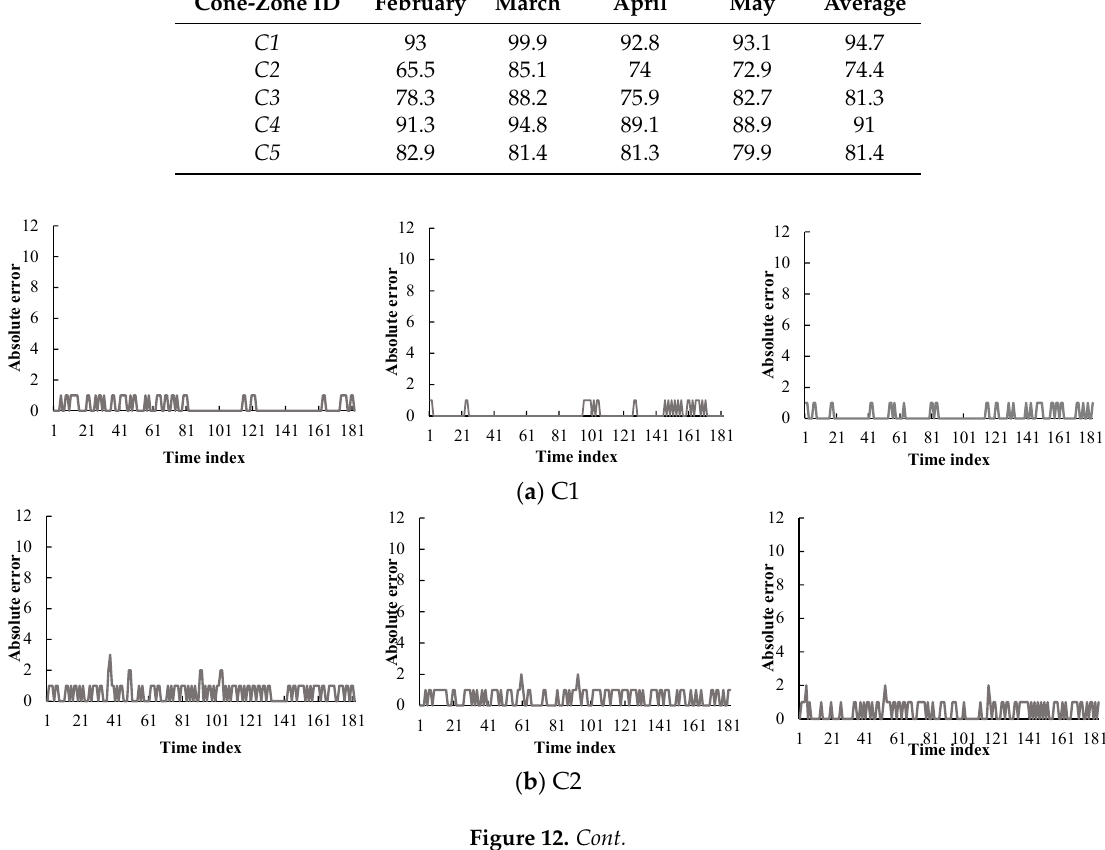
Figure 12. Cont. Figure 12.